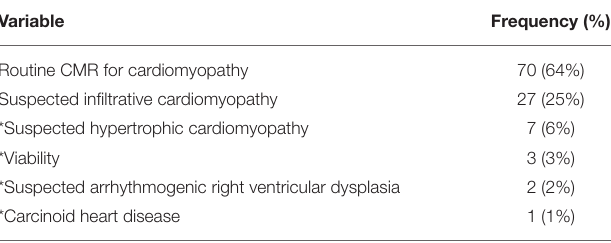
TABLE 2 | CMR indications.